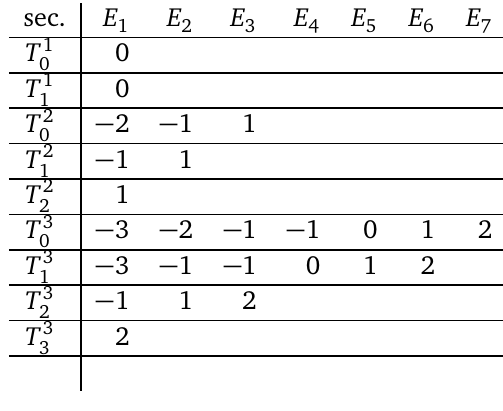
Table 1: Energy eigenvalues in the smallest triplet sectors T (cid:96) length (cid:96) = 3 in the fully frustrated ladder ( δ = 0) with J (cid:48) = 1. All eigenvalues are integers, leading to coherent oscillations in the OTOC and entanglement dynamics.